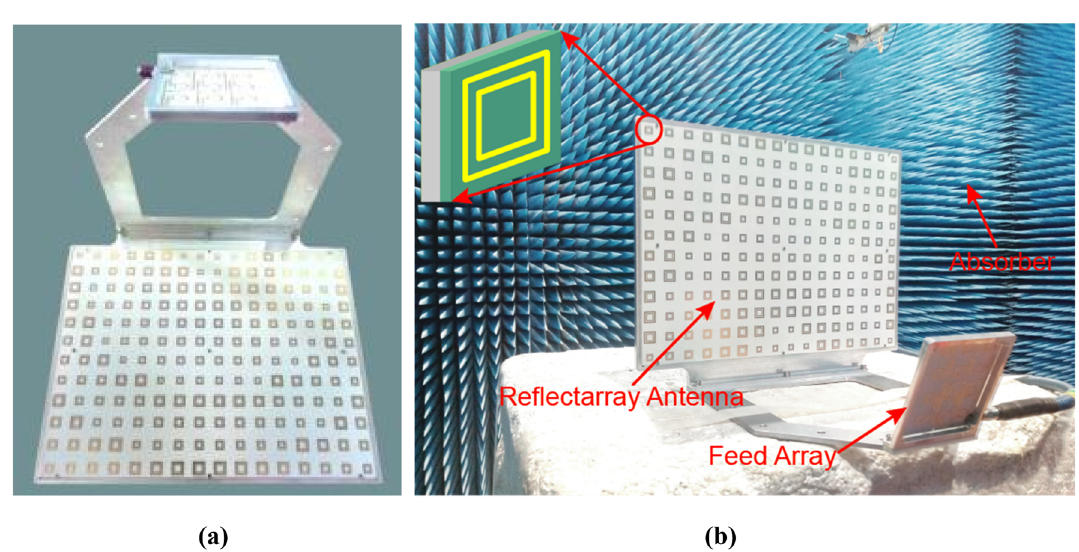
Figure 10. Photograph of the reflectarray antenna: (a) the prototype and (b) the prototype in an anechoic